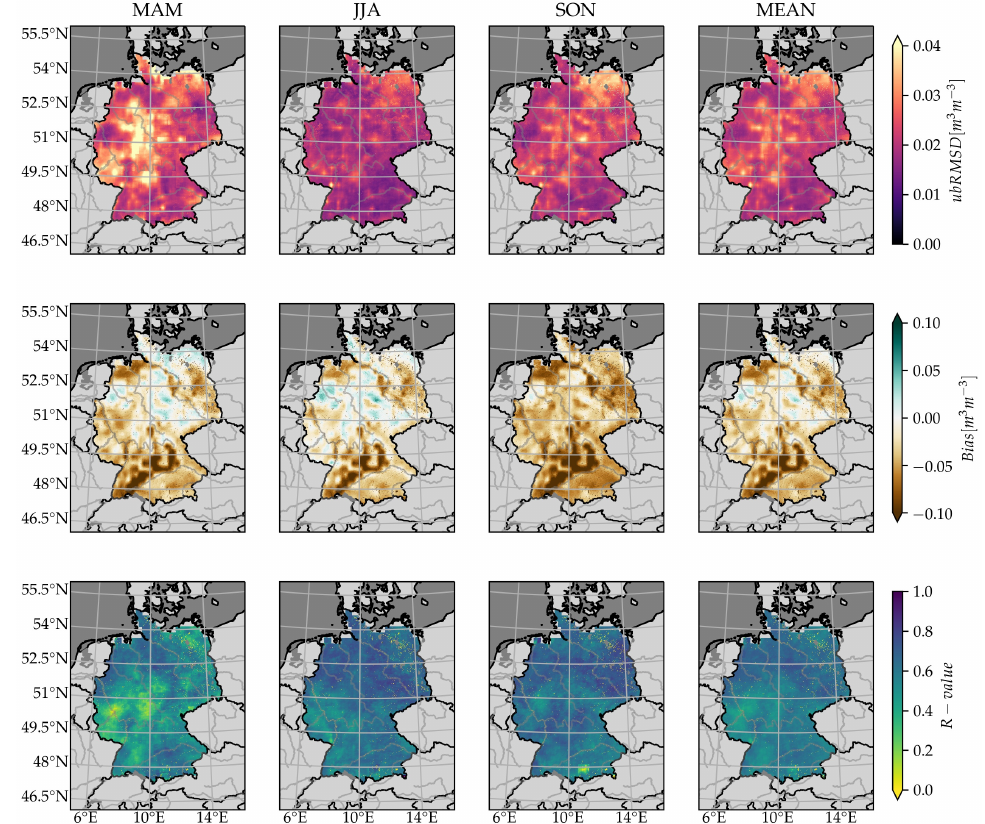
Figure 5. ubRMSD , bias , and R between API and ESA CCI SM data for seasons MAM, JJA, SON and mean of the seasonal measures.